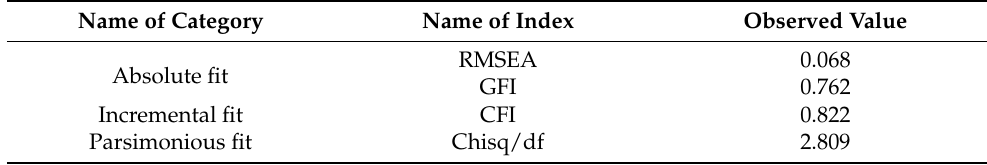
Table 2. Model Fit Value for the Proposed